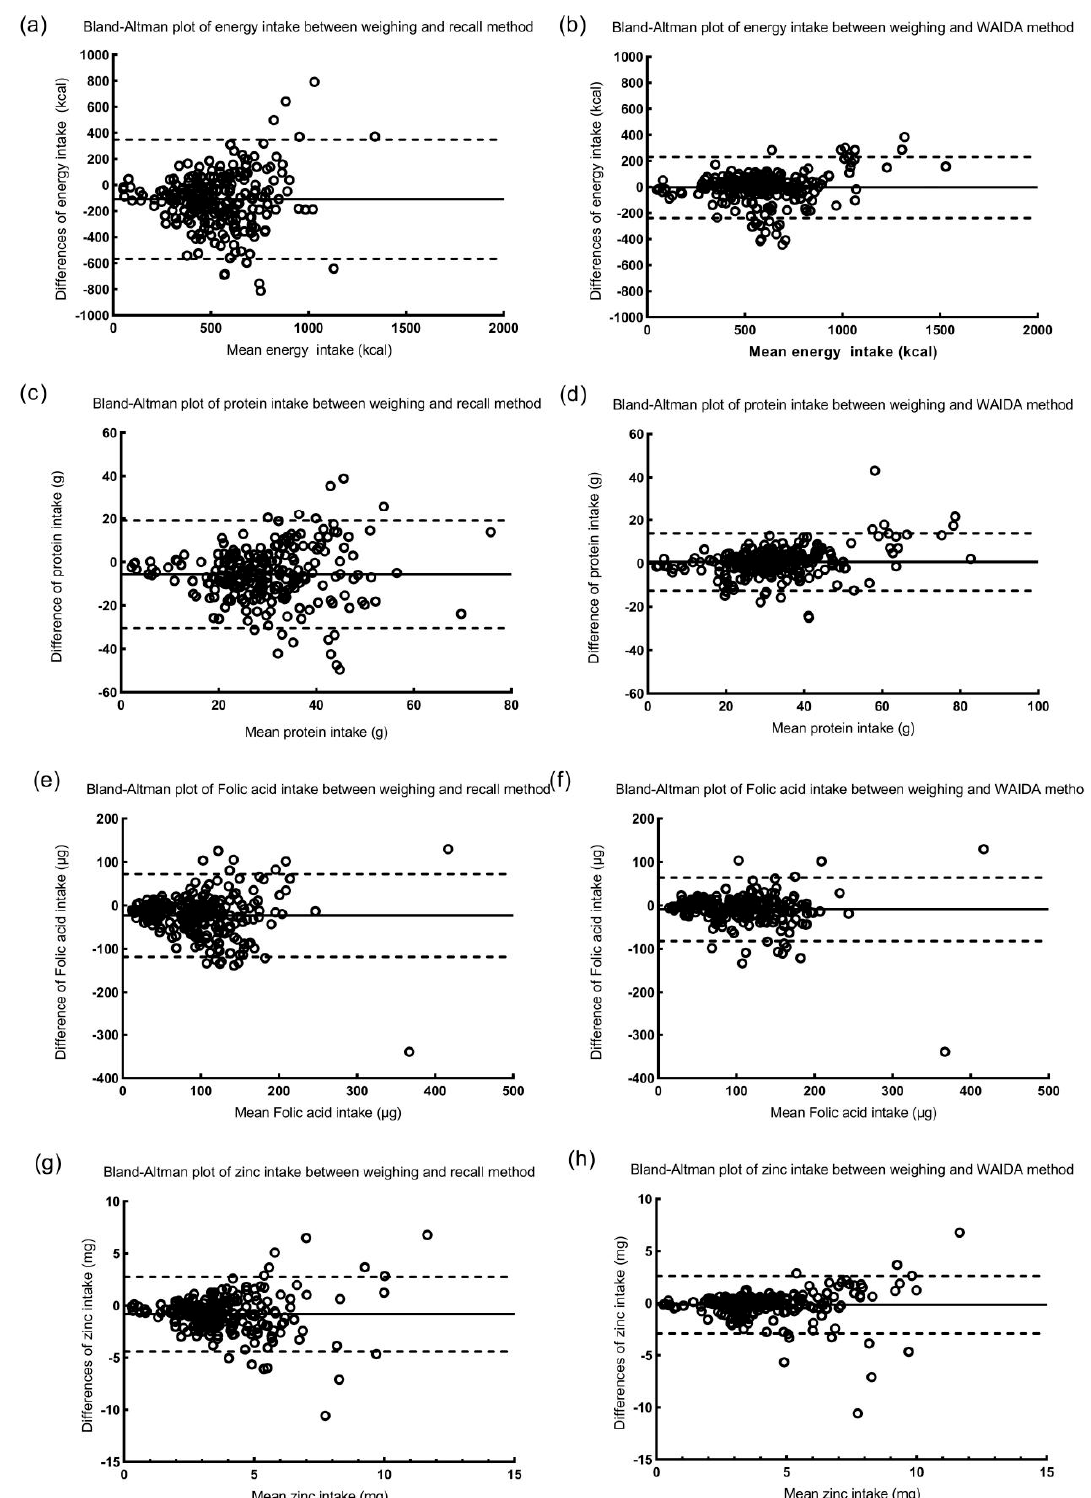
Figure 3. Bland-Altman plots showing the proportional biases of ( a , b ) energy, ( c , d ) protein, ( e , f ) folic acid, and ( g , h ) zinc intakes between the weighing method and recall or WAIDA method for 251 meals. The solid lines represent mean difference and the dashed lines represent the 95% limits of agreement (standard deviation 1.96).